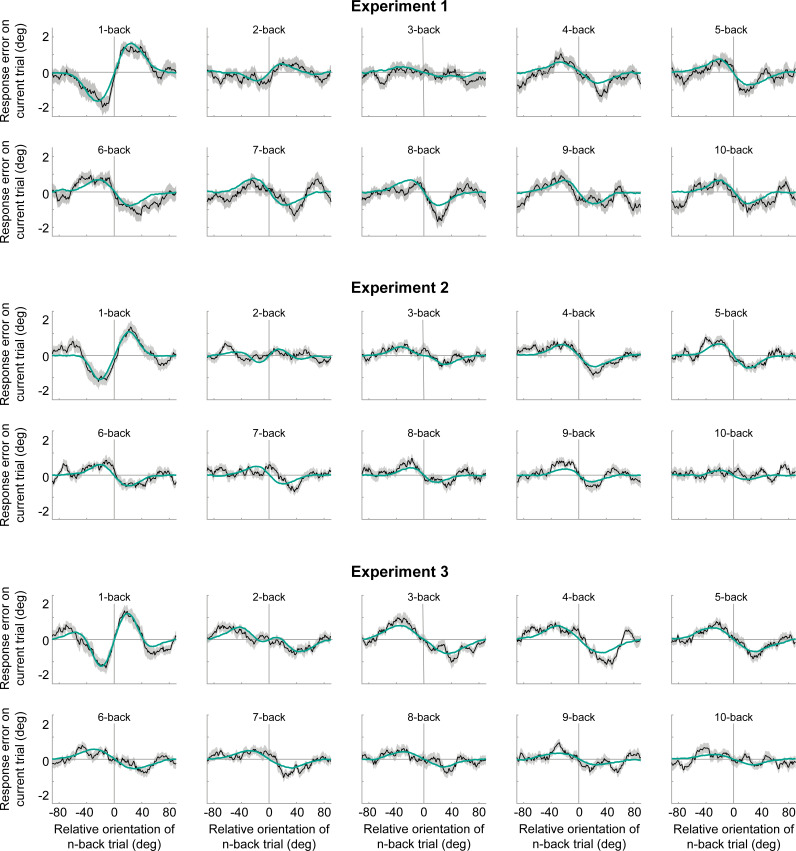
Serial dependence biases of an ideal observer with efficient encoding and history-dependent Bayesian decoding (green).The model can accurately capture the tuning profile of short-term attraction and long-term repulsion biases across Experiments 1–3. Model biases were computed by simulating the ideal observer model on the stimulus sequences shown to human participants. Human serial dependence biases are shown in black. Shaded regions denote SEMs of the empirical data.